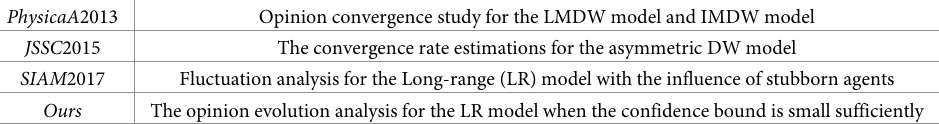
Table 1. Comparison between our work and some previous